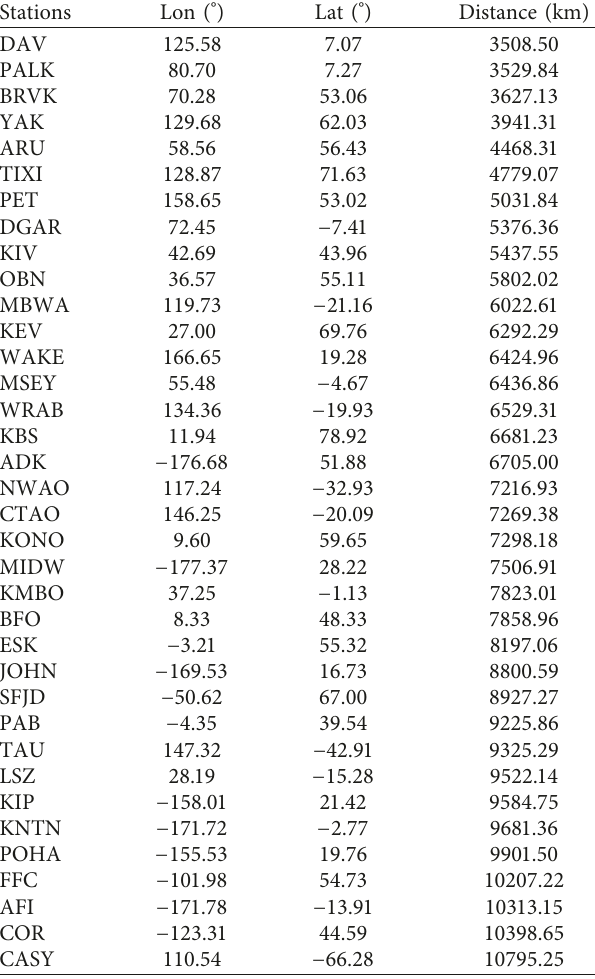
Table 2: Locations and epicentral distances of 36 teleseismic